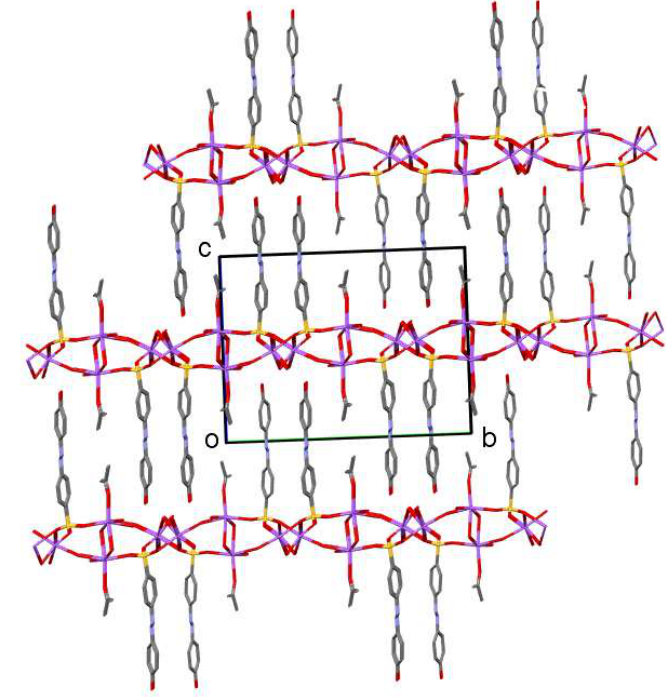
Figure 9. Contents of the asymmetric unit of the 2-dimensional coordination polymer [K 3 ( 3 )( 3* )(OH 2 )]. Both K2 and K3 interact with azo bonds and all three K centres form π bonds to aromatic groups.